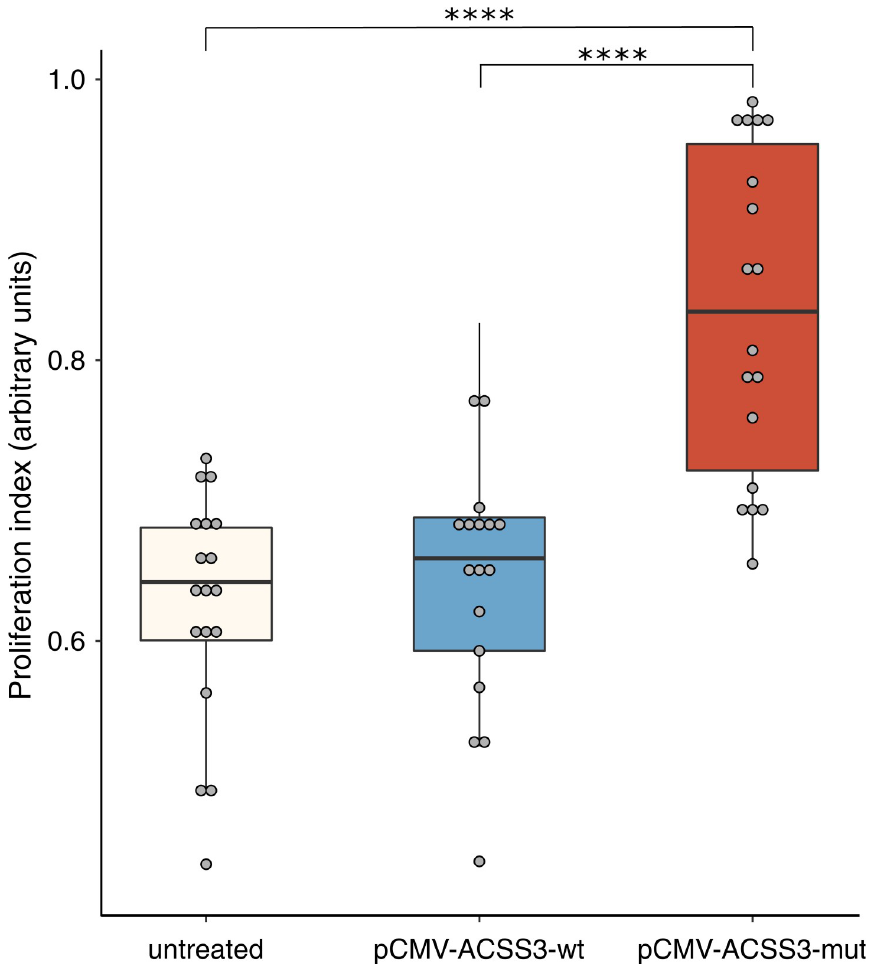
Fig 4. The p.P532S mutation in ACSS3 stimulates cell proliferation. CRMM-1 cells were left untreated or transfected with a plasmid containing a wild-type ACSS3 cDNA (pCMV-ACSS3-wt) or a cDNA containing the mutation p.P532S (pCMV-ACSS3-mut). Proliferation was assessed after 24 hours, by means of the MTT colorimetric test. Data are indicated in arbitrary units, corresponding to background-corrected absorbance values at 570 nm. Asterisks indicate significant p-values (6.91x10 -7 between untreated and pCMV-ACSS3-mut and 3.39x10 -6 between pCMV-ACSS3-wt and pCMV-ACSS3-mut, by t-test).